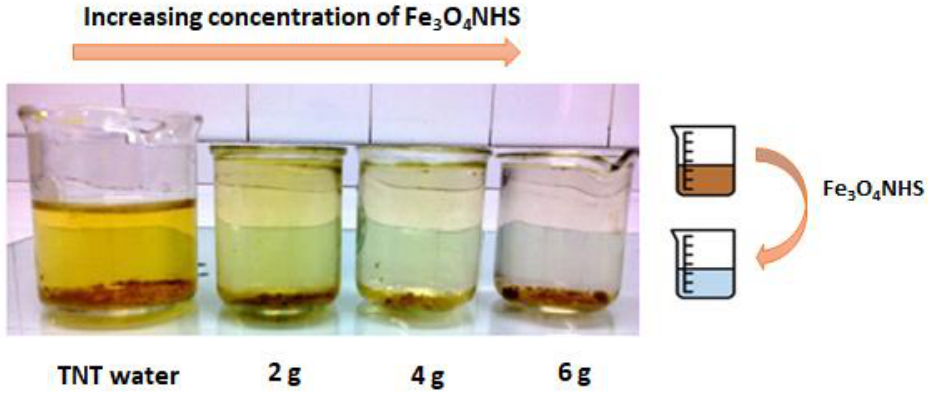
Figure 10. More toxins in the TNT wastewater are bound to the surface of Fe 3 O 4 NHS added to the mixture. This yields clearer water with increasing Fe 3 O 4 NHS present.